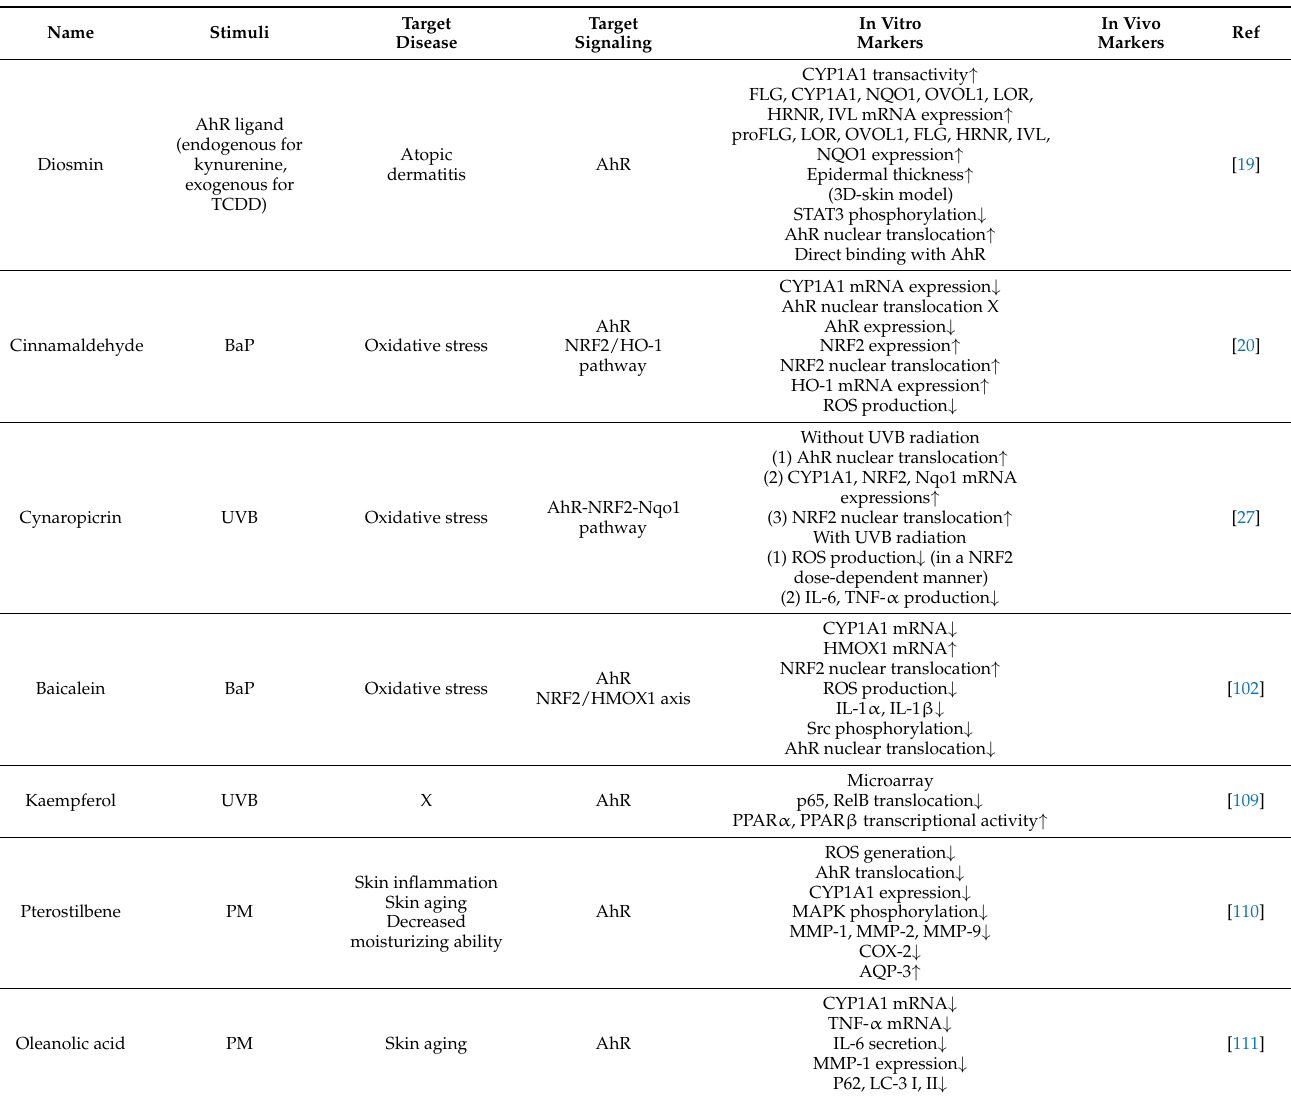
Table 3. Molecular functions of AhR-targeted phytochemicals in skin